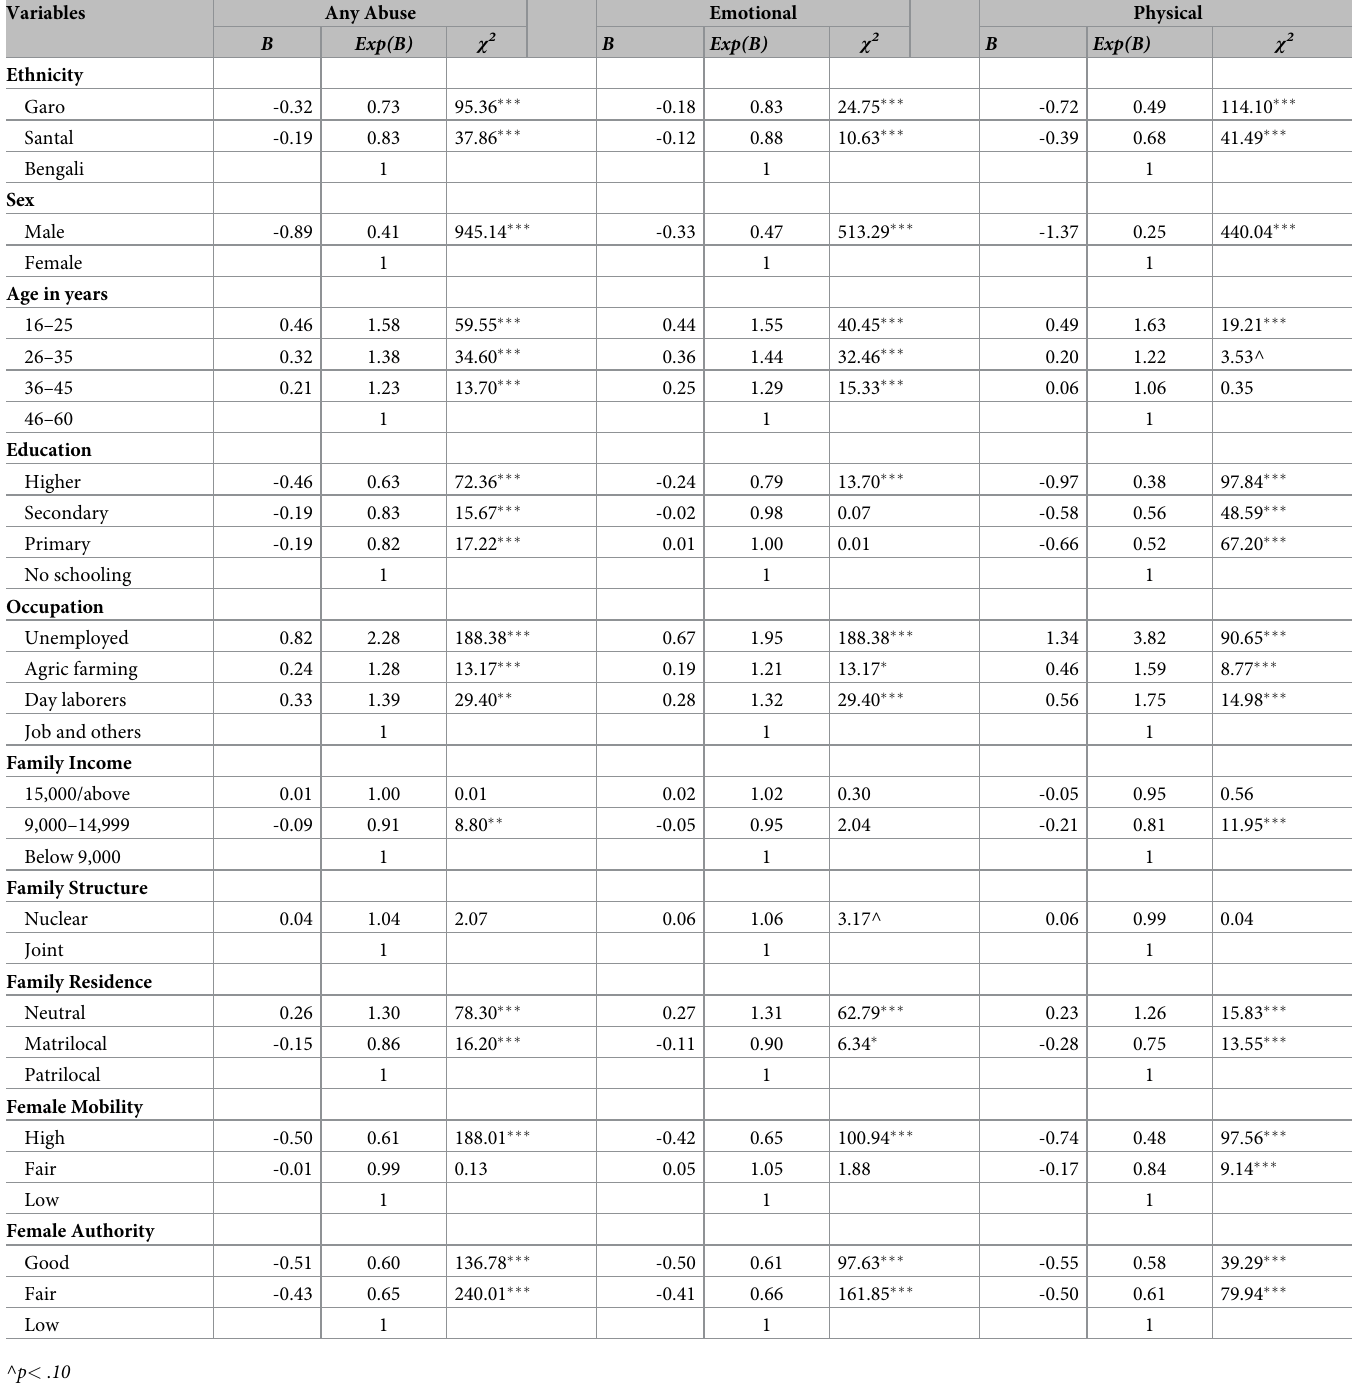
Table 3. Bivariate poisson regressions for the events where wife abuses are accepted, N =